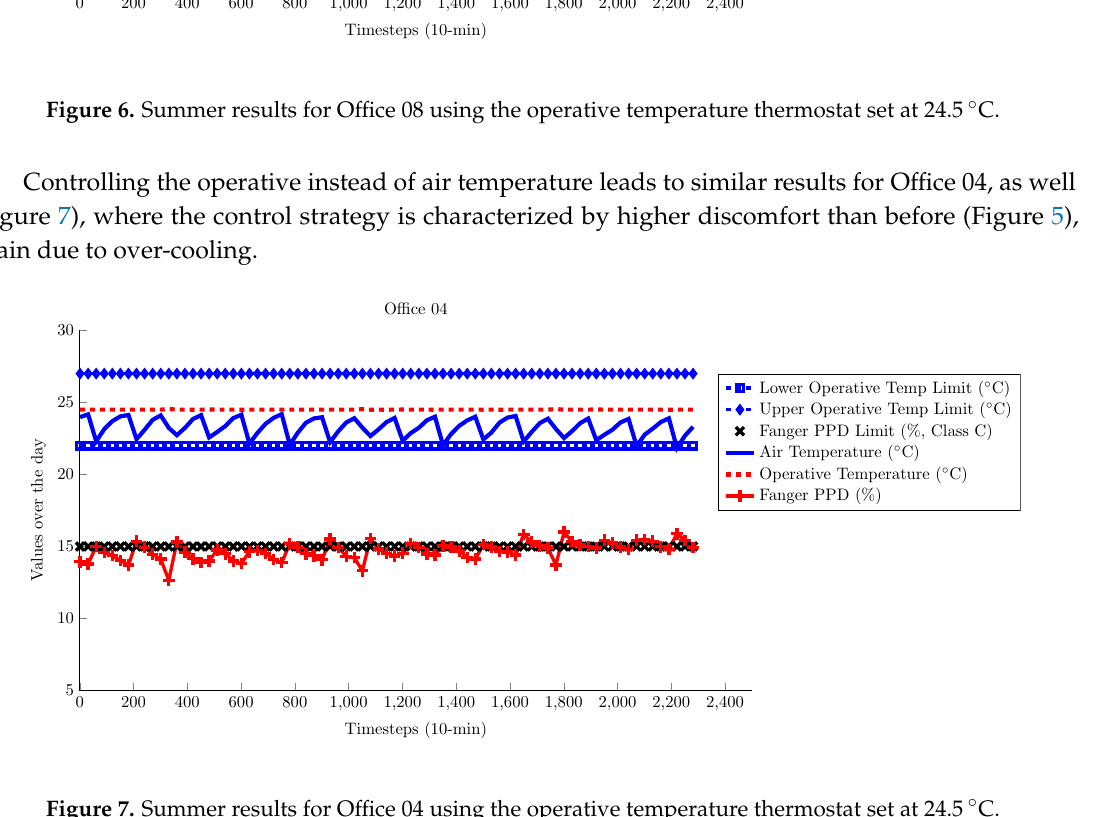
Figure 7. Summer results for Office 04 using the operative temperature thermostat set at 24.5 ◦